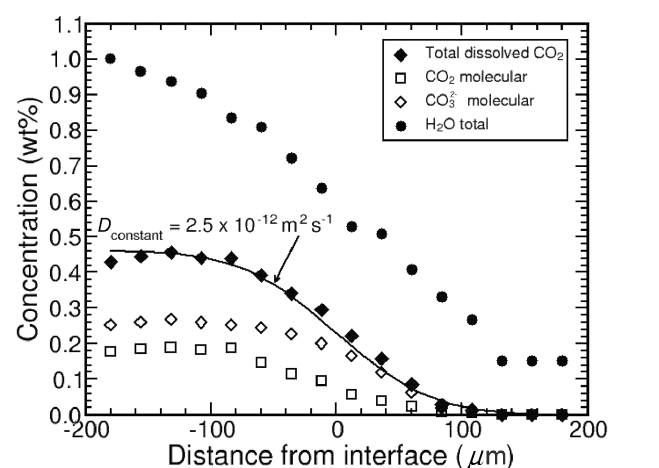
Fig. 3. Carbon dioxide diffusion in trachyte melt from a diffusion couple experiment at 1.2 GPa, 1200ºC, and 720 s. Diffusion profiles are displayed for total water, molecular CO 2 , carbonate, and total CO 2 , calculated as the sum of molecular CO 2 and carbonate. Concentrations of all species were determined by FTIR as discussed in the text. Also plotted is the theoretical diffusion profile for a diffusion coefficient of 2.5 × 10 − 12 m 2 s − 1 . Further details of this experiment can be found in the